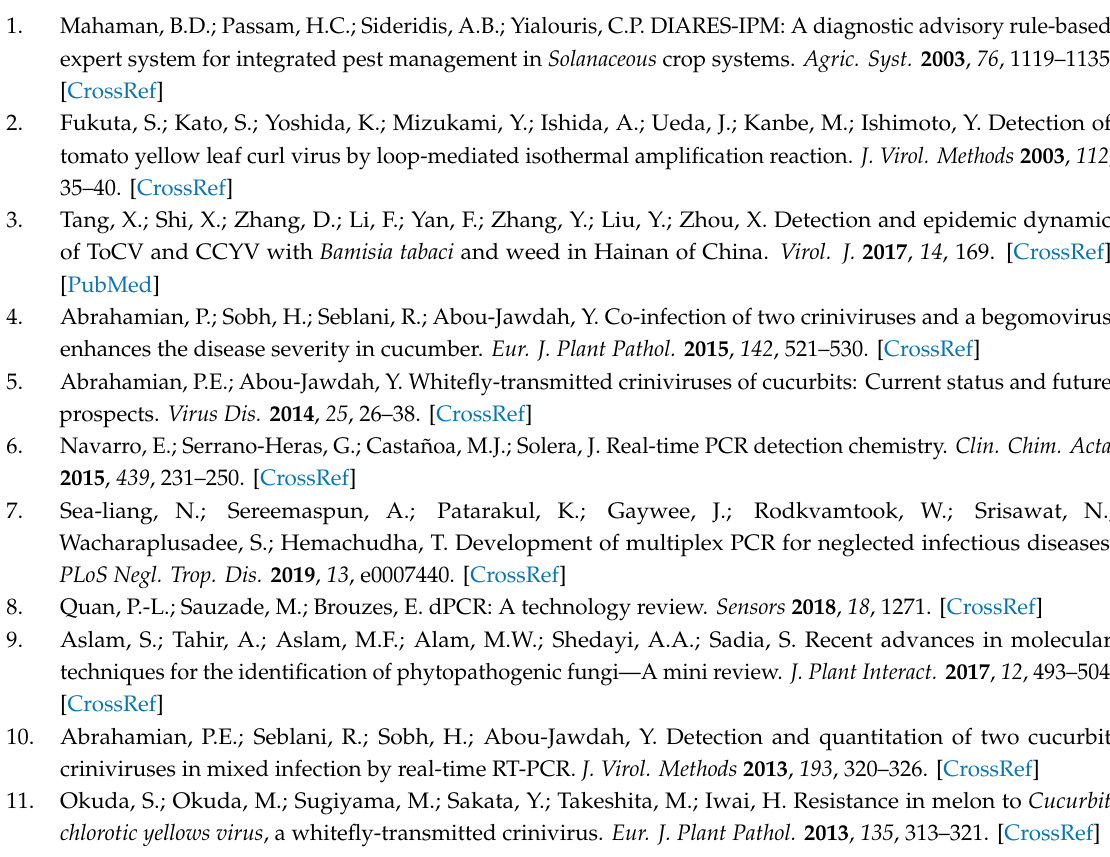
for selecting excitation wavelength ranges; Table S3: The average fluorescence intensities (after 60 min) either in the positive chambers (Nos. 2 and 4) or the negative chambers (Nos. 1, 3, and 5), and the intensity ratio (P / N) of negative (N) to positive (P); Figure S1: A comparison of the fluorescence intensity of the six di ff erent combinations of the two berberine compounds and three optical filter cubes (i.e., three di ff erent excitation wavelength ranges) estimated before and after the LAMP assay for 30 and 60 min in the microfluidic diagnostic devices; Figure S2: Homemade equipment for smartphone-based fluorescence imaging during multiplex LAMP assays in microfluidic diagnostic devices; Figure S3: Fluorescence images were taken with a smartphone after the LAMP assay (60 min) with berberine chloride and berberine sulfate. The positive reaction chambers (Nos. 2 and 4) are denoted by arrows in the photographs. The fluorescence intensity ratios (P / N) are also presented in the figure; Figure S4: Changes in fluorescence intensities as a function of the reaction time showing the RT-LAMP detection of an RNA-based plant virus (cucumber mosaic virus, CMV). The concentration of total RNA, containing the CMV viral RNA target, was 17.6 ng / µ L after mixing with the LAMP reagents; Figure S5: Changes in fluorescence intensities as a function of the reaction time. RT-LAMP was used to detect an RNA-based plant virus (kyuri green mottle mosaic virus, KGMMV). The concentrations of total RNA, containing the KGMMV viral RNA target, were (a) 19.0 and (b) 3.0 ng / µ L after mixing with the LAMP reagents. Video S1: Autonomous sample dispensing into an array of